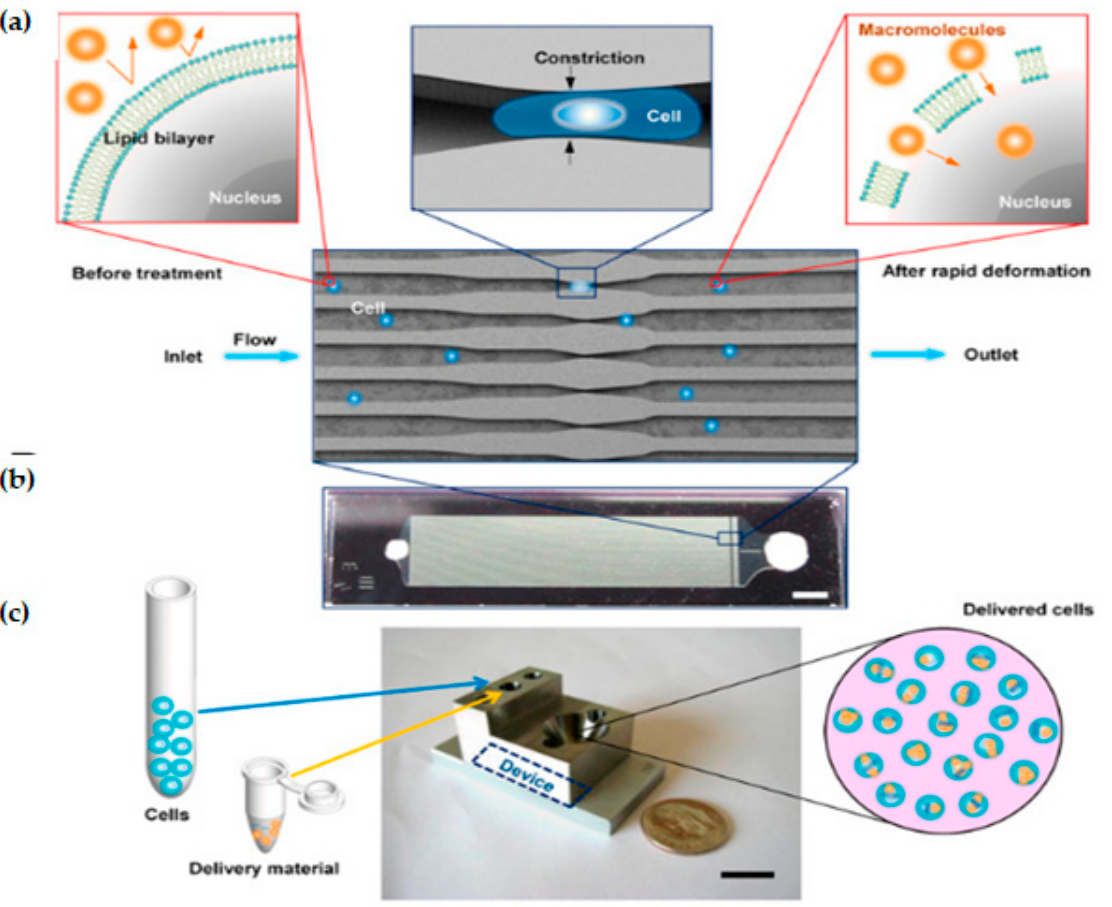
Figure 4. Device design and mechanism. ( a ) Schematic of delivery hypothesis where cell passes across a microfluidic constriction, deforms, and creates transient membrane holes. ( b ) Image of a device consisting of Pyrex bound to silicon for sealing (Scale bar: 2 mm). ( c ) Schematic of the delivery procedure in which cells and delivery material are mixed in the inlet reservoir, run through the chip, and collected in the outlet reservoir (Scale bar: 10 mm). Reprinted with permission from ref. [80]. Copyright © 2013 Proceedings of the National Academy of Sciences.